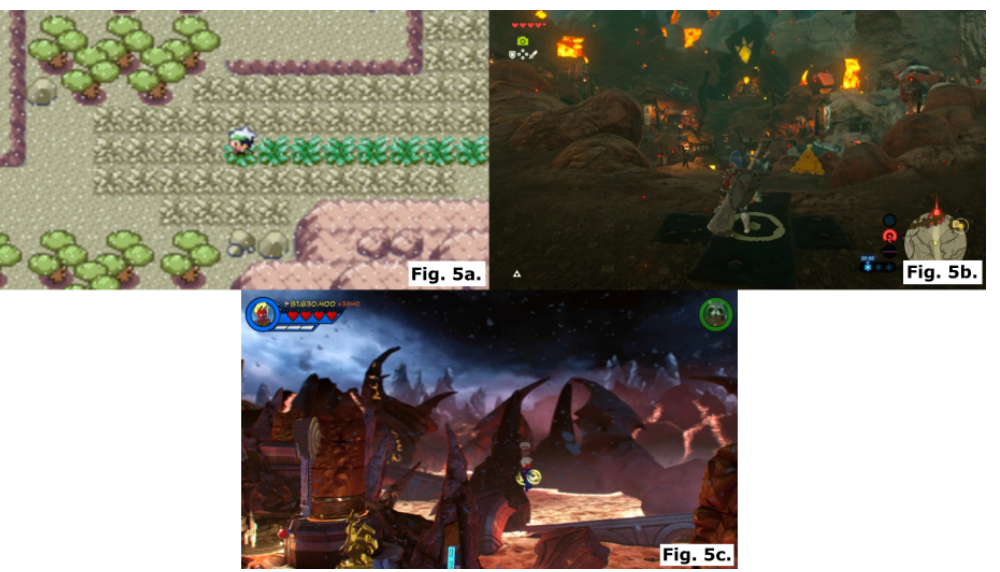
Figure 5. Volcanic ash visual effects in Pokémon Emerald © The Pokémon Company (2005; a ), The Legend of Zelda: Breath of the Wild © Nintendo (2017; b ) and LEGO Marvel Superheroes 2 © TT Games Ltd (2017; c